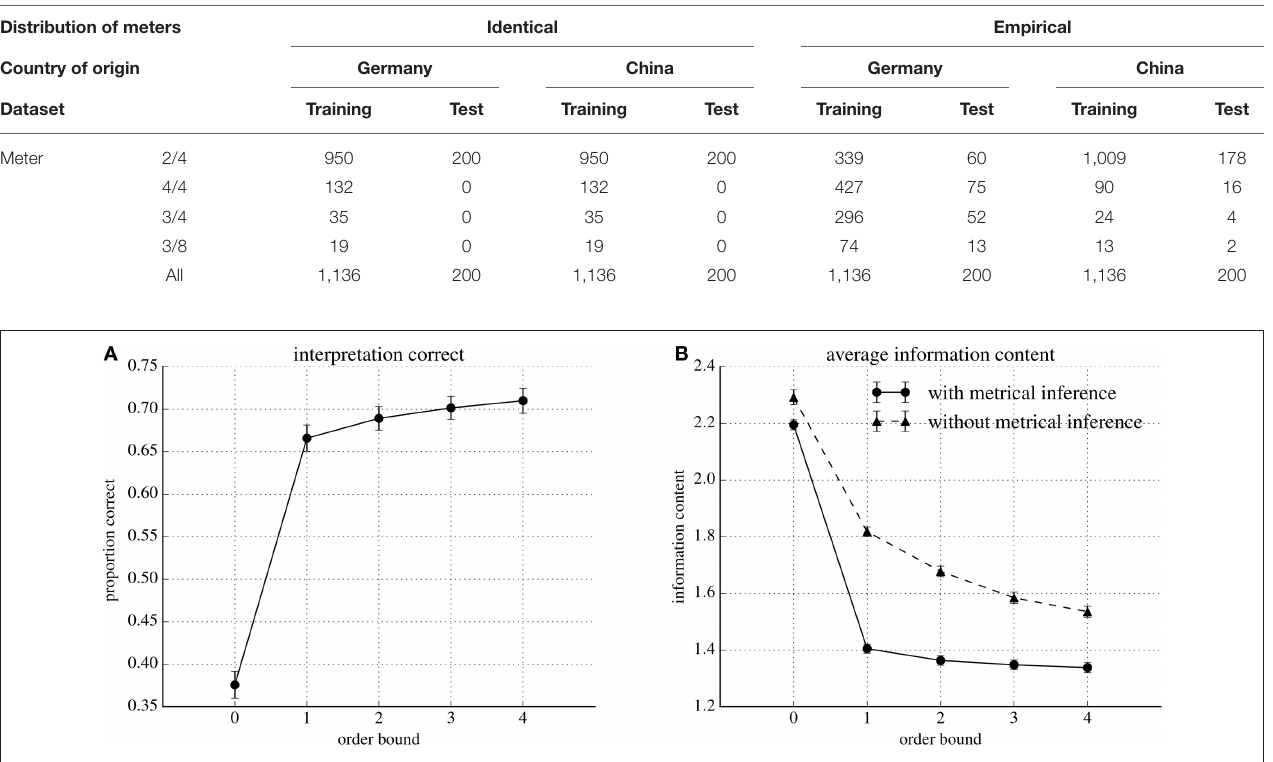
TABLE 2 | Number of rhythms in different metrical categories in the training and test sets used in the simulation of enculturation. Distribution of meters Identical Empirical Country of origin Dataset